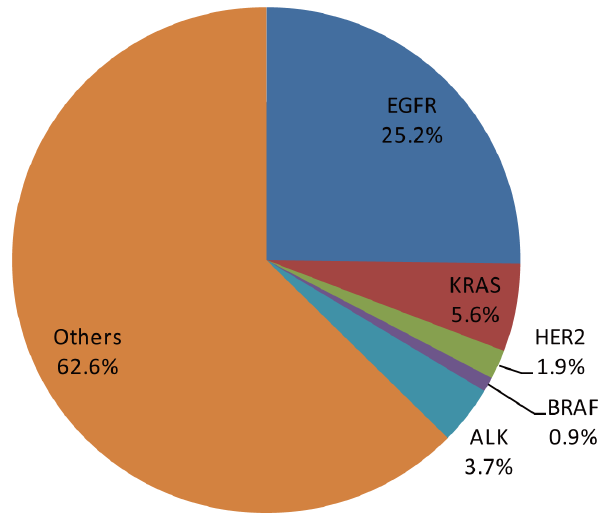
Figure 1. Pie chart of EGFR, KRAS, HER2 and BRAF mutation spectrum from 107 lung adenocarcinomas. The mutation rates of EGFR, KRAS, HER2 and BRAF were 25.2, 5.6, 1.8 and 0.9%, respectively.